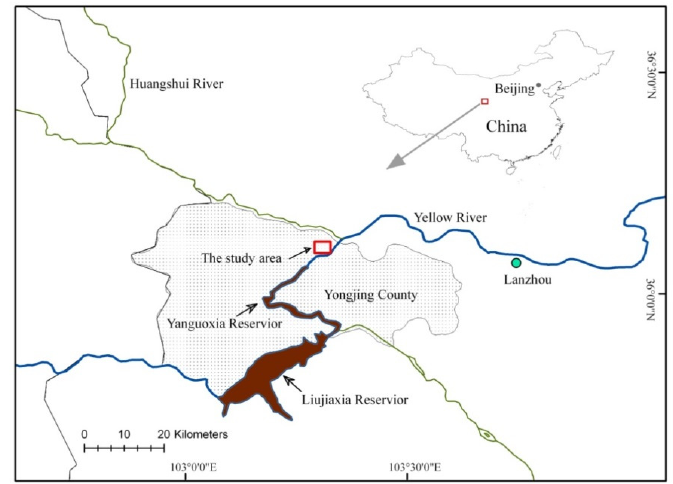
Figure 2. Geographical location of the study area.